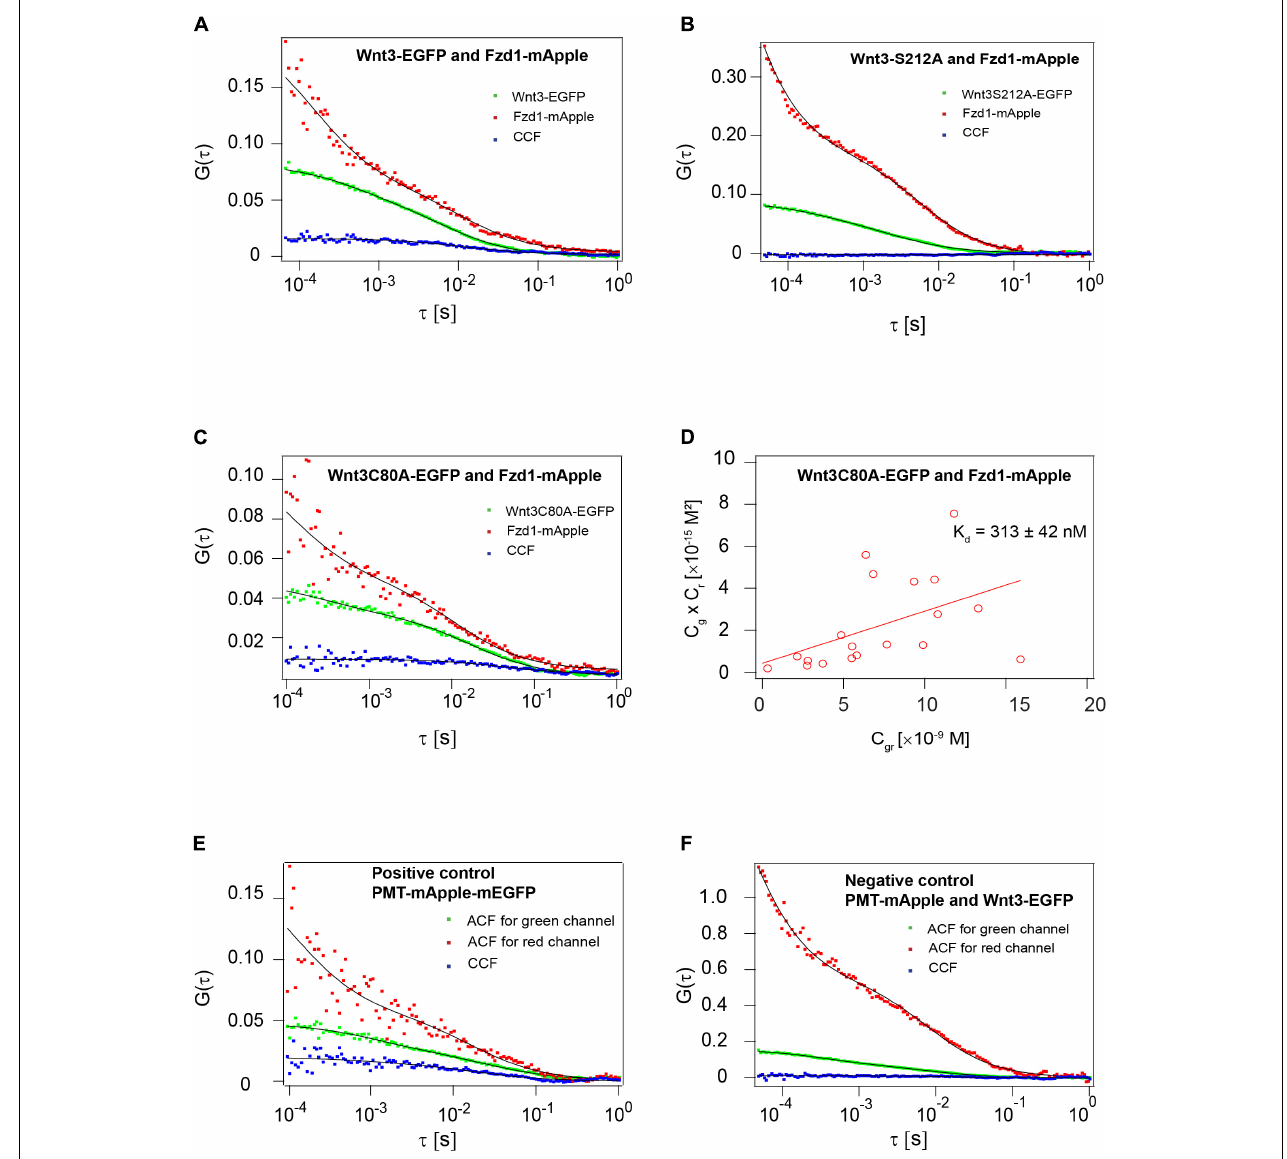
FIGURE 8 | Influence of C80 and S212 lipidation on the interaction of Wnt3 with Fzd1 receptor. (A) Representative auto- and cross-correlation functions (dots) and fits (lines) of a Wnt3-EGFP and Fzd1mApple FCCS measurement. The positive cross-correlation function indicates Wnt3EGFP interacts with Fzd1mApple in vivo . (B) Representative auto- and cross-correlation functions (dots) and fits (lines) of a Wnt3S212A-EGFP and Fzd1mApple FCCS measurement. No cross-correlation function indicates Wnt3S212A-EGFP does not interact with Fzd1mApple in vivo . (C) Representative auto- and cross-correlation functions (dots) and fits (lines) of Wnt3C80A-EGFP and Fzd1mApple. The positive cross-correlation function indicates Wnt3C80-EGFP interacts with Fzd1mApple in vivo . (D) Determination of apparent dissociation constant (K d ) for Wnt3C80A-EGFP and Fzd1mApple interaction in vivo . Cg, Cr, and Cgr represents the concentration of unbound Wnt3C80A-EGFP, unbound Fzd1mApple, and bound Wnt3C80A-EGFP and Fzd1mApple molecules, respectively. The estimated apparent K d (cid:0) K (cid:14) C (cid:1) for Wnt3C80A-EGFP and Fzd1mApple in vivo is 313 ± 42 nM. (E) Representative auto- and cross-correlation functions for PMT-mApple-mEGFP which is a positive control showing a clear cross-correlation. (F) Representative auto- and cross-correlation functions for embryos co-expressing PMT-mApple and PMT-mEGFP as a negative